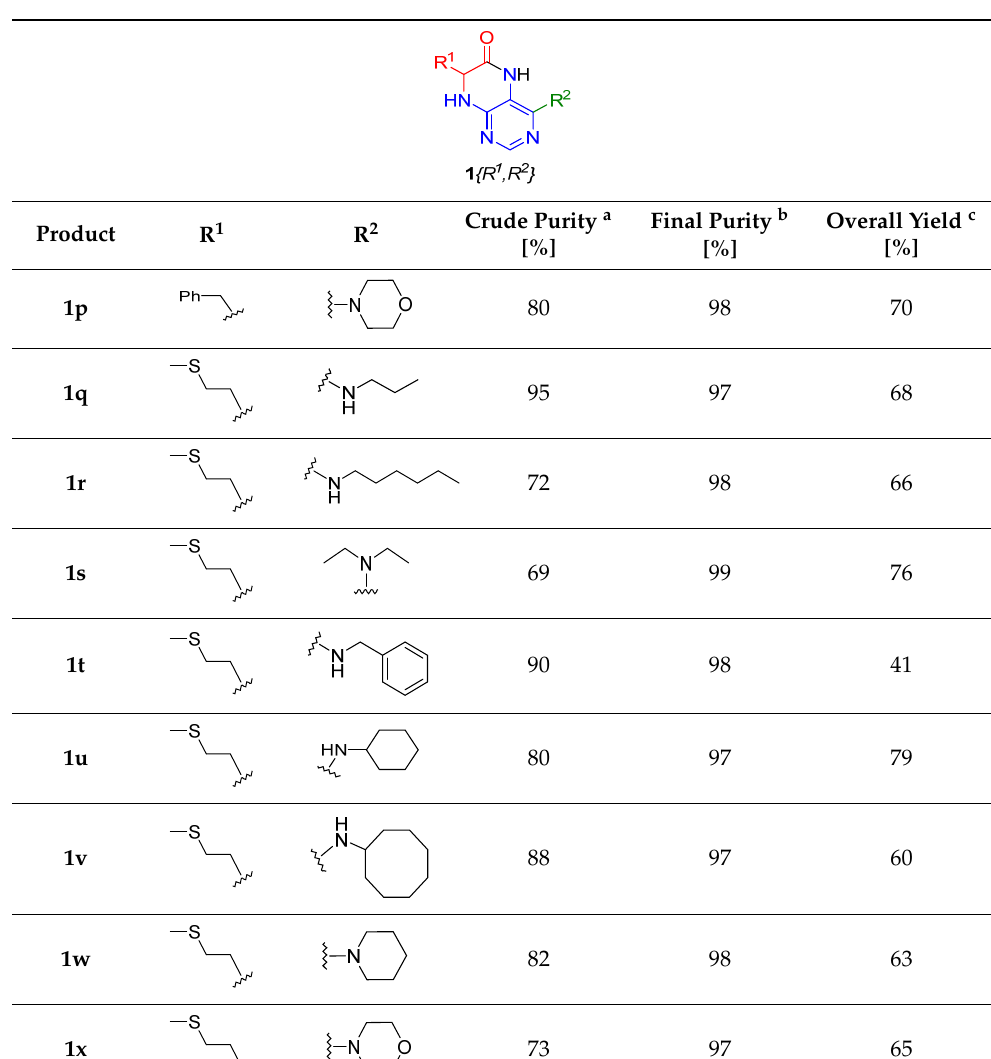
Table 1. Cont. Table 1. Overview of synthesized dihydropteridinones 1